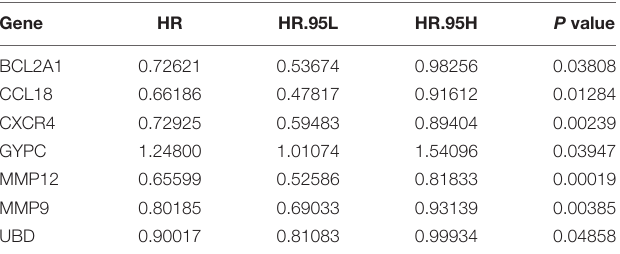
TABLE 1 | Identification of prognosis related signature by Univariate Cox